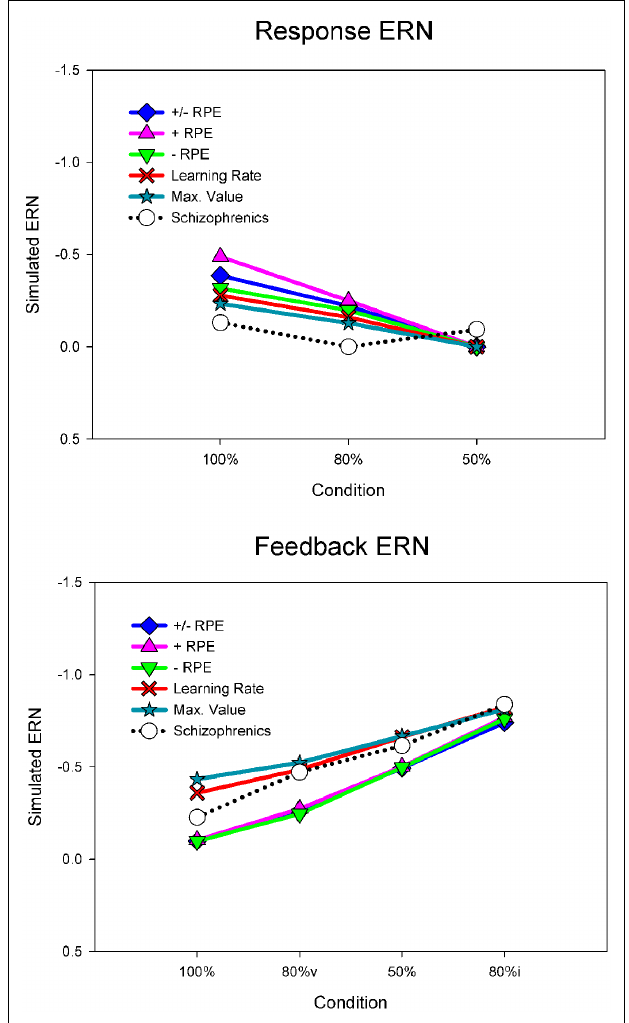
FIGURE 9 | Error-related negativity difference wave data for the probabilistic learning task, for the response ERN (top) and feedback ERN (bottom), for the simulated and empirical schizophrenia data. Note that “80%v” and “80%i” correspond to 80% condition trials with either valid or invalid feedback, respectively. Empirical data are from